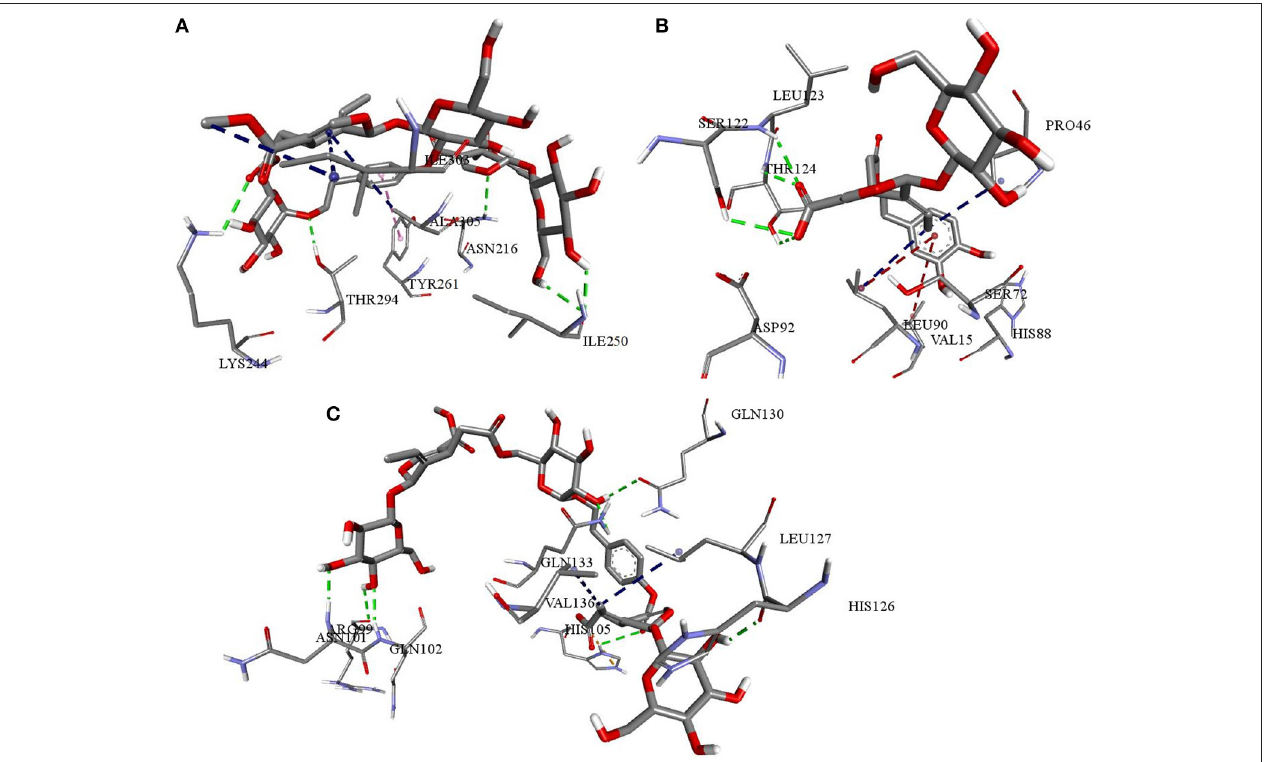
FIGURE 11 | Interactions of NZO and DMO with cytokine receptors (A) NZO interactions with IL1R (B) DMO interactions with IL6R (C) NZO interactions with TNFR1. Green color bonds are the hydrogen bonds, Red color bonds are the π -alkyl, and Blue color bonds are the alkyl-alkyl interactions.